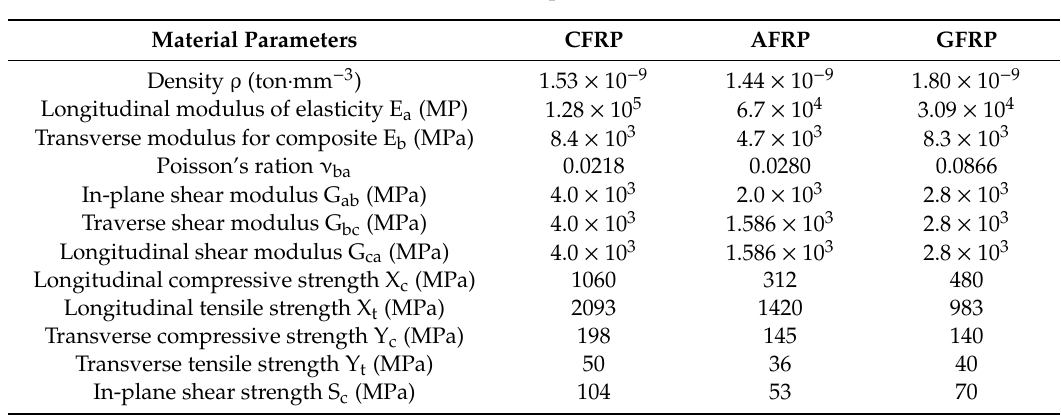
Table 3. The material parameters of